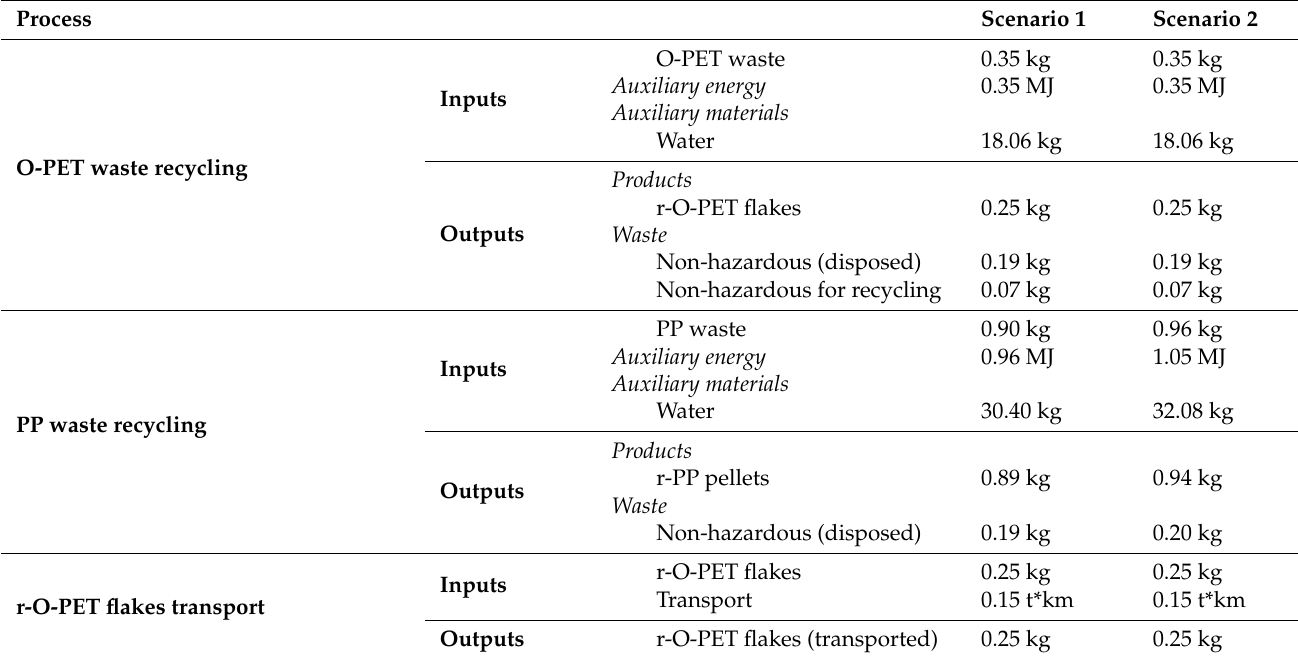
Table 4. Inventory of inputs and outputs included in the system boundaries for the production of 1 kg of pellets (functional unit) for both recycling